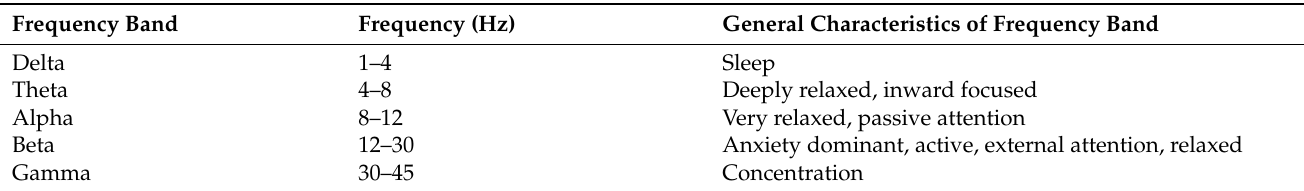
Table 1. Brain frequency bands and their general